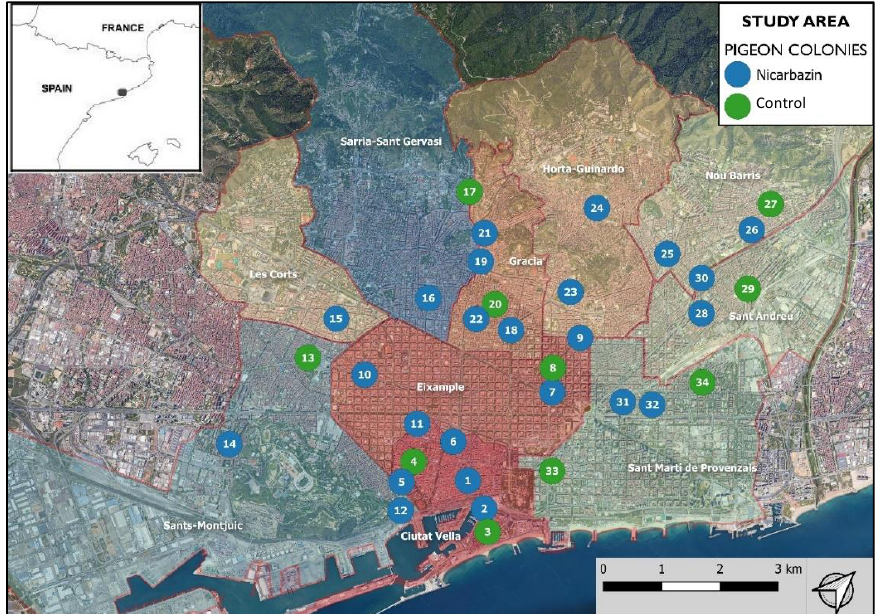
Figure 1. Study area. Location of the 34 conflictive colonies included in the study, divided in the treatment groups (test, nicarbazin; and control, control) of the 2017 superiority study.